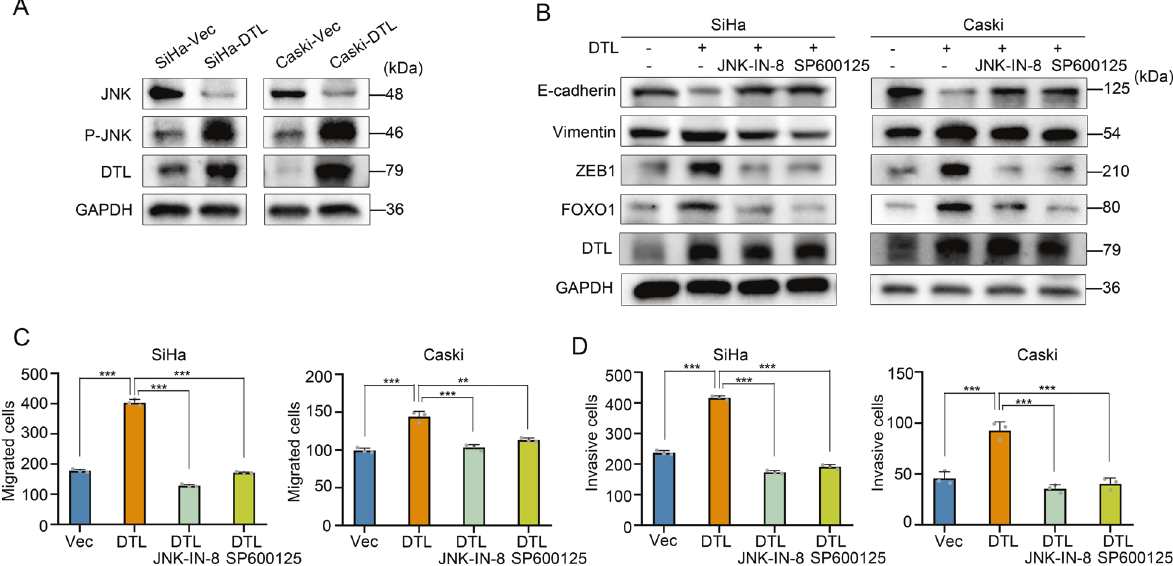
Fig. 4 JNK mediates DTL-induced EMT, FOXO1 upregulation, cell migration, and invasion. A Western blotting showed that DTL overexpression induced JNK phosphorylation. B DTL-induced EMT was suppressed by JNK inhibitor (JNK-IN-8 and SP600125). C , D Quanti fi ed data of transwell migration ( C ) or invasion ( D ) assay in SiHa and Caski cells. Error bars indicate the mean ± SD of three independent experiments. Student ’ s t -test; * P < 0.05, ** P < 0.01, *** P < 0.001. Cell Death and Disease (2021)